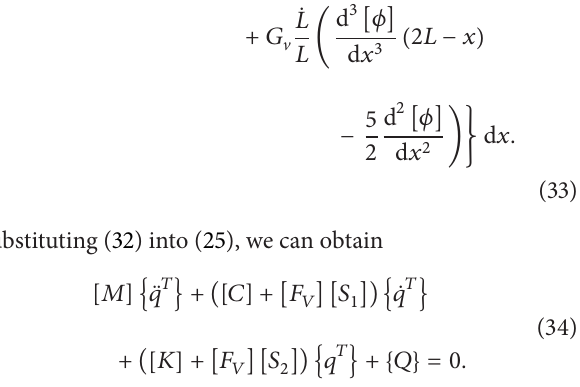
Figure 6: Tip trajectory of the arm when 𝐿(𝑡) = 2 − 0.2𝑡 ,